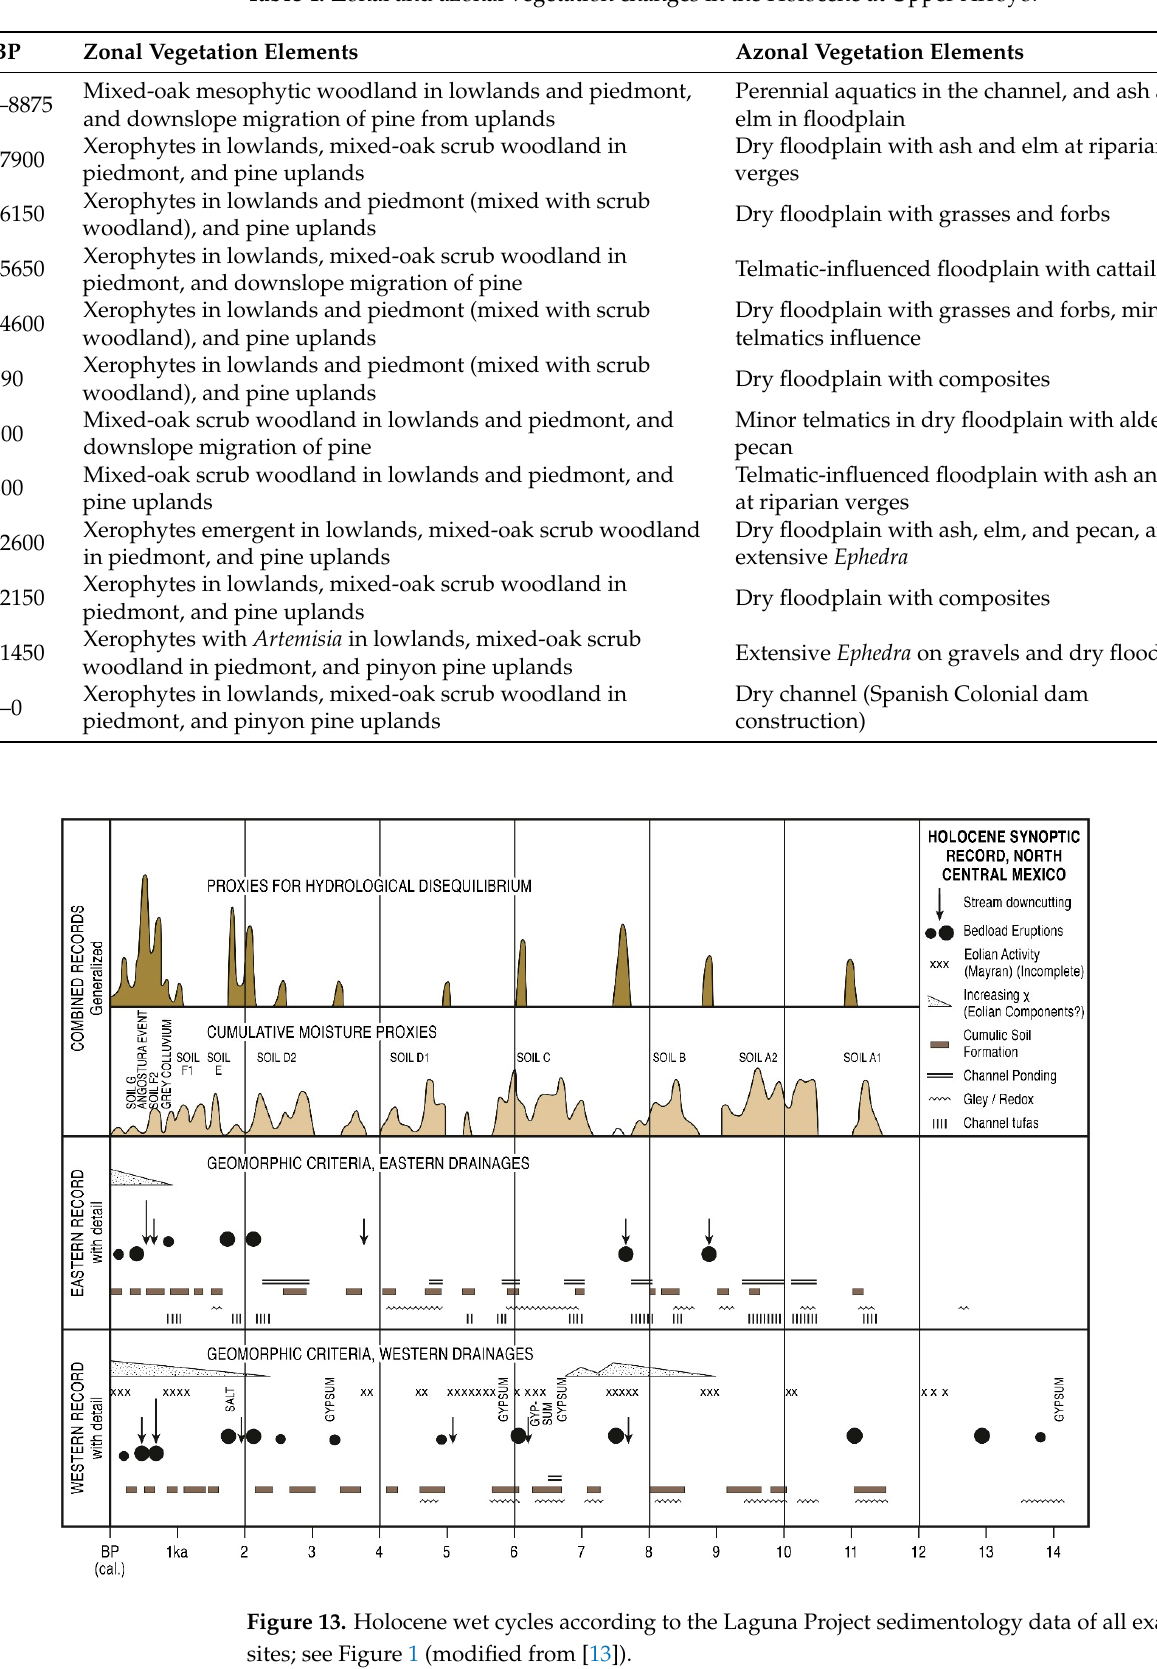
haploxylon (cf. P. cembroides )), scrub woodland, and xerophytic vegetation being main- tained in the upland, piedmont, and lowlands in relatively static zonal positions. Before considering these developments in southern Coahuila, let us first take note of the pollen and sediment records from other parts of Subtropical Mexico so as to help distinguish broader inter-regional patterns from those of a local character. 6.2. Comparative Environmental Records in North and Central Mexico The results of the Upper Arroyo pollen analyses summarized above invite general comparisons with other environmental records from subtropical Mexico, including pol- len, geochemical, and isotopic records from terrestrial paleosols. These records uniformly indicated a cyclical trend toward progressive desertification in the middle-to-late Holo- cene, with temporal horizons of cycles being significant at secular, century-level time- scales. Desertification can be defined here in terms of low lake levels, increased erosion and accumulation in soil profiles, high levels of xerophyte pollen at lowland pollen sites, upslope migration of tree limits recorded at highland pollen sites, and enhanced carbon isotope levels in dated paleosols. Phase relationships could be identified within the limits of dating that suggest the importance of climatic changes in some records.